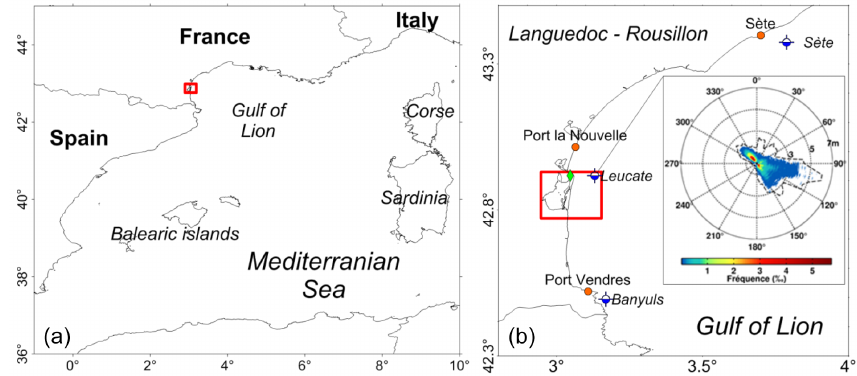
Figure 1. Location map (a) and magnification (b) . Circles are for tide gauges locations, crosses for buoys locations and diamond for Leucate meteorological station. The red rectangle delimits the domain used for simulation ( R 0